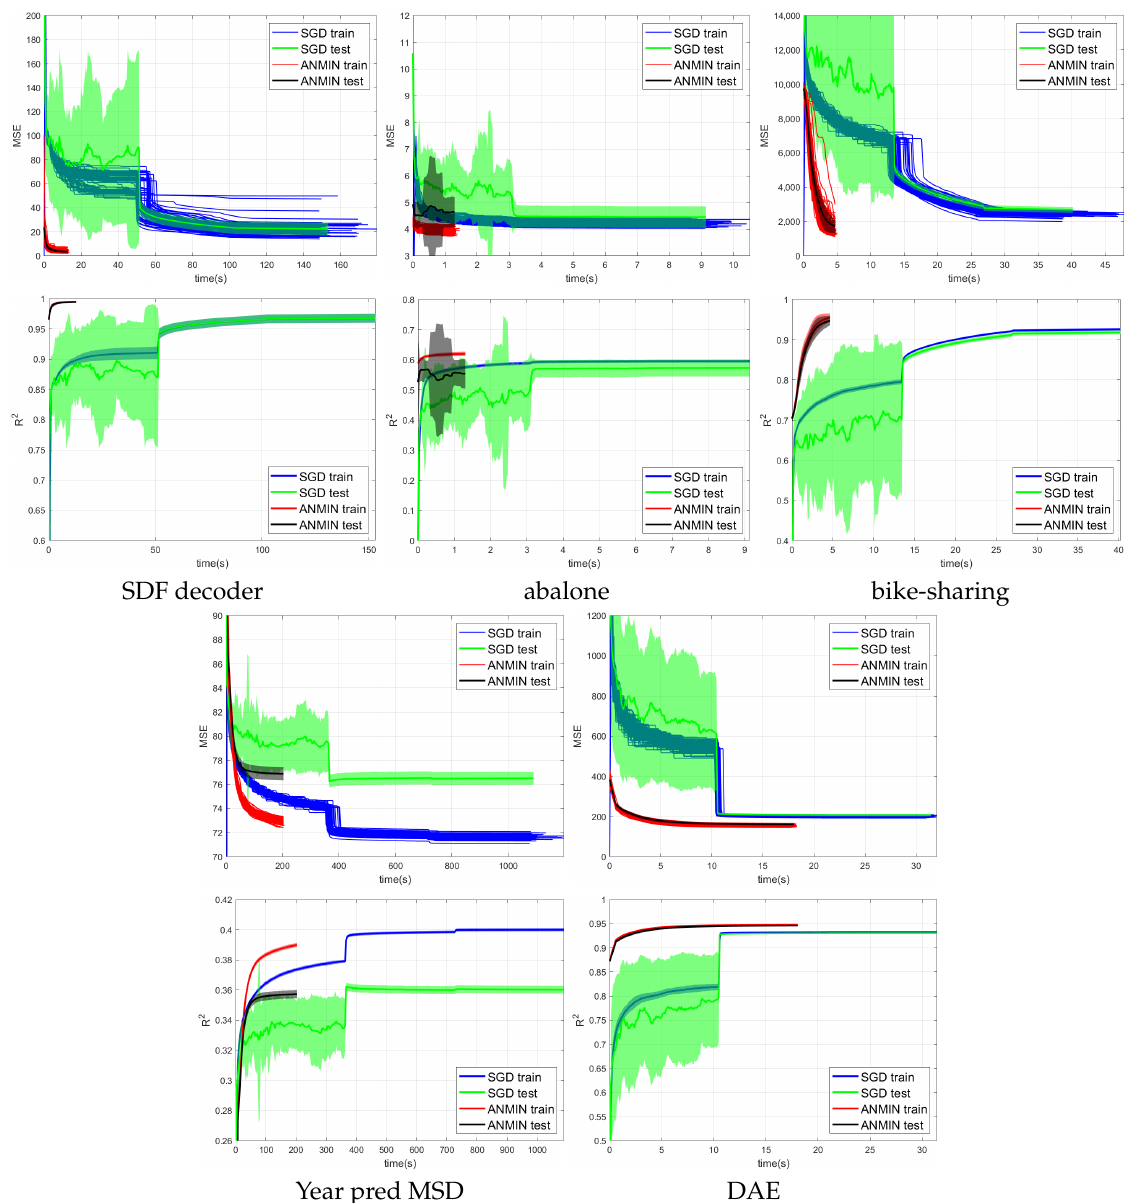
Figure 5. MSE and average R 2 vs. time (seconds) of 100 runs of training the NN with ReLU activation using the SGD and ANMIN optimizers. Additionally plotted are the mean test MSEs and R 2 with standard